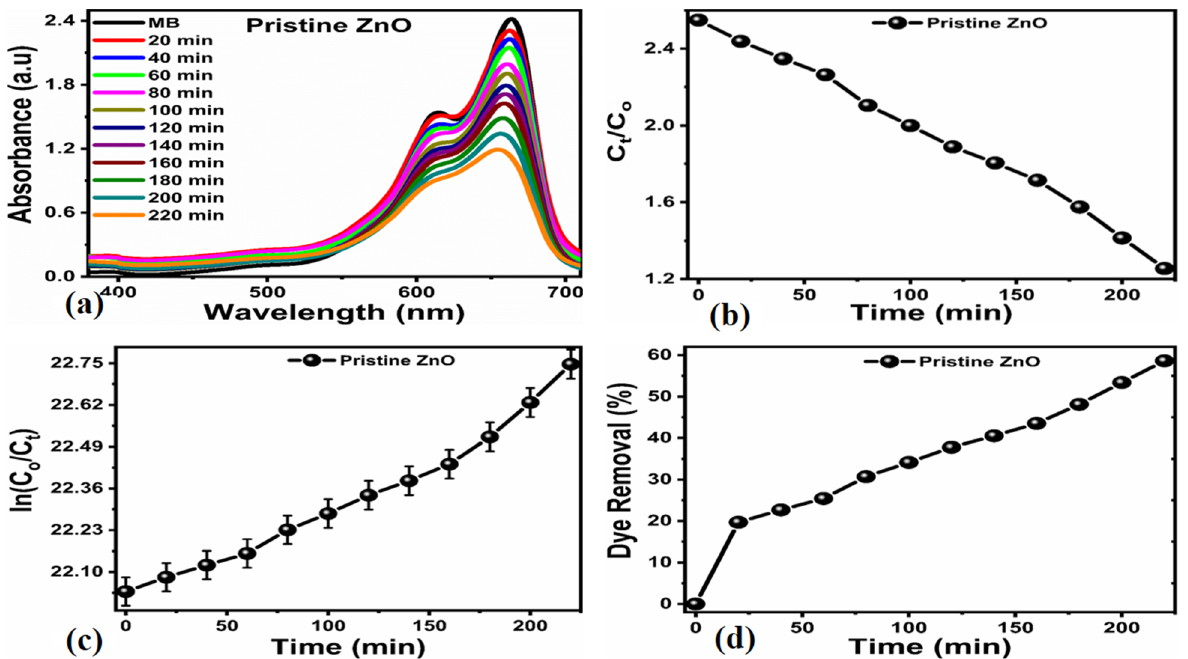
Figure 6. ( a ) Absorption spectra for pristine ZnO, ( b ) Ct/Co vs time curve for, ( c ) kinetics of photodegradation for ZnO towards MB, and ( d ) dye degradation efficiency graph.